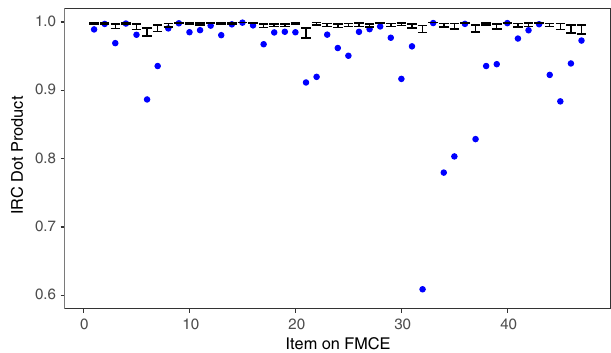
FIG. 5. The IRC dot product for each item on the FMCE is shown in blue for the IDW American (IDWA) and Japanese (IDWJ) datasets [30]. The black error bars represent the ran- domized trial confidence intervals described in Sec. III B 3.